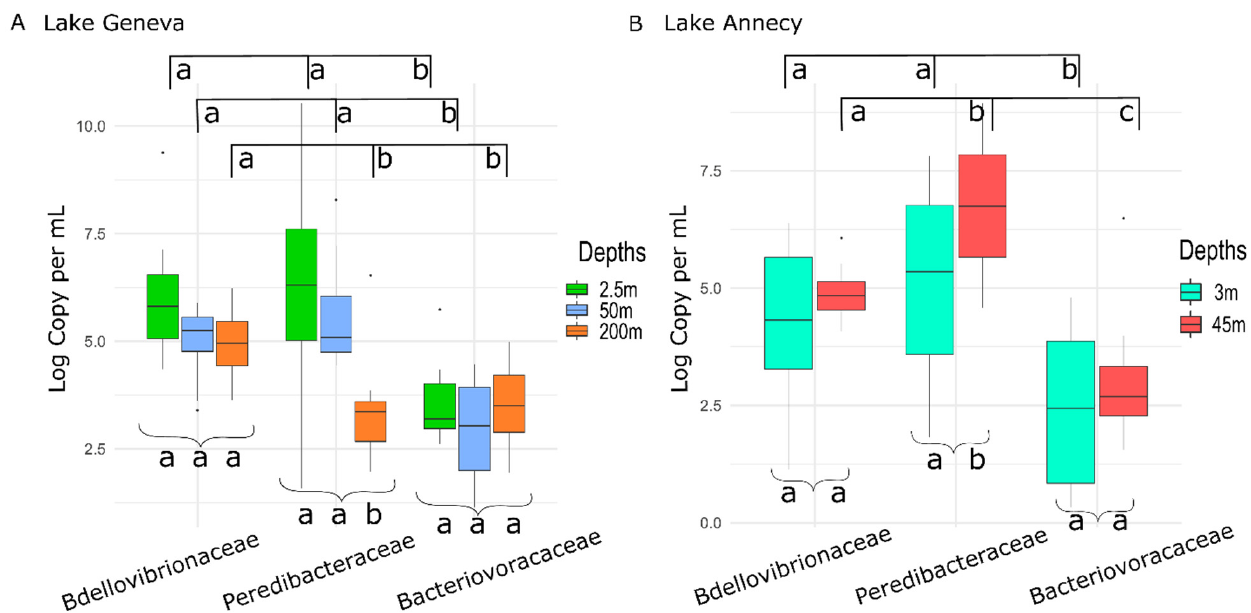
Figure 2. Mean values of the three BALOs at the studied depths of Lakes Geneva and Annecy ( n = 12 for each boxplot). Brackets are used to illustrate the comparison for a family of predators between the different depths studied. Square brackets display the comparison between the predators for a similar depth. Letters represent the statistical significance ( p < 0.05) of differences between the studied groups.